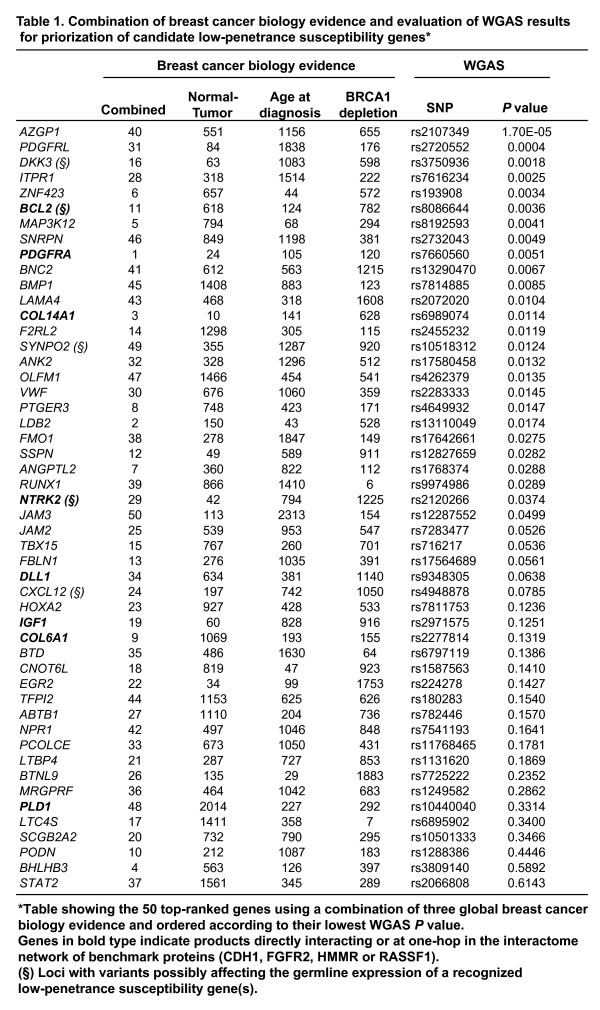
Combination of breast cancer biology evidence and evaluation of WGAS results for priorization of candidate low-penetrance susceptibility genes